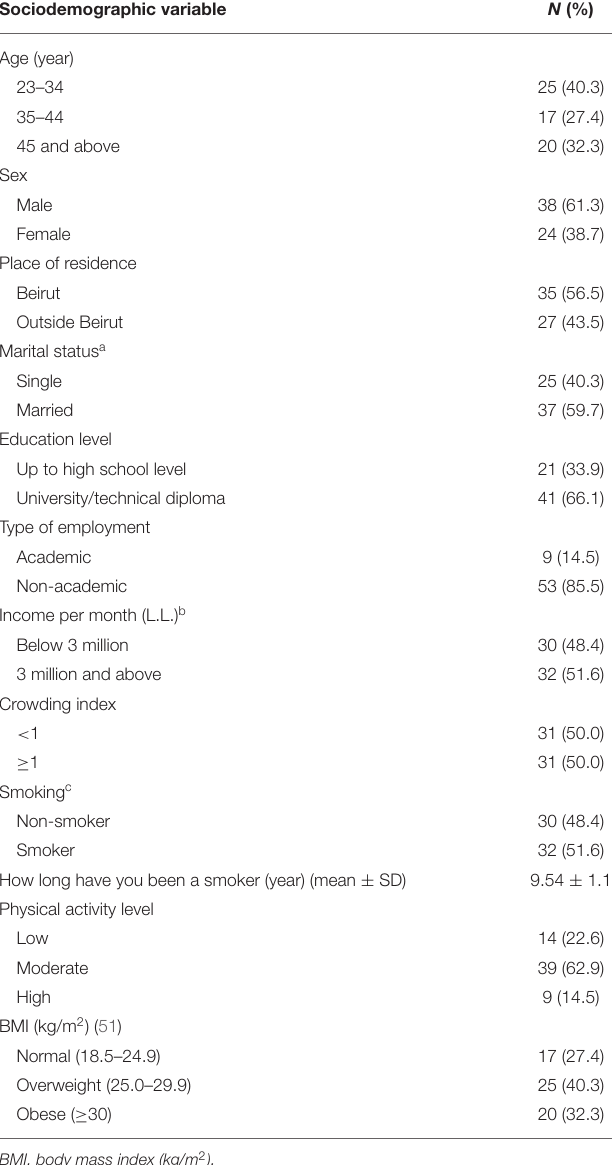
TABLE 1 | Sociodemographic and lifestyle characteristics of the study population ( n =